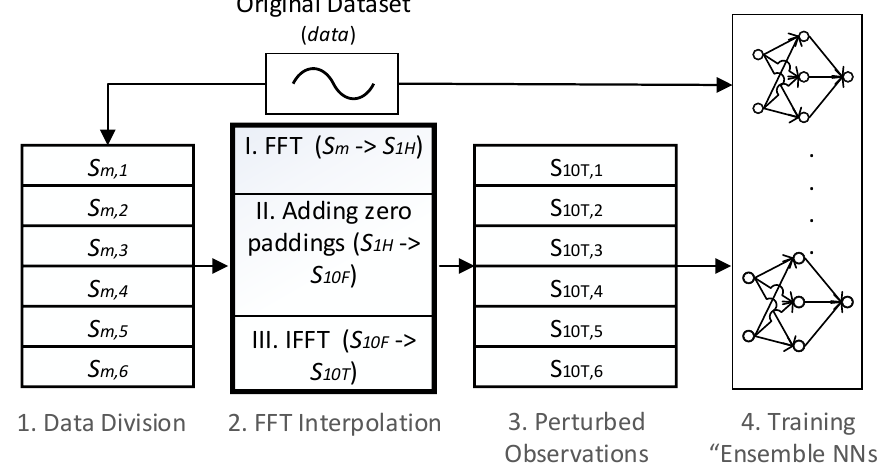
Figure 5. Proposed training procedure. A total of 7 ensemble network were used: Six ensemble networks were trained using the six perturbed datasets that were obtained from fast Fourier transform (FFT) interpolation and one with the original dataset.